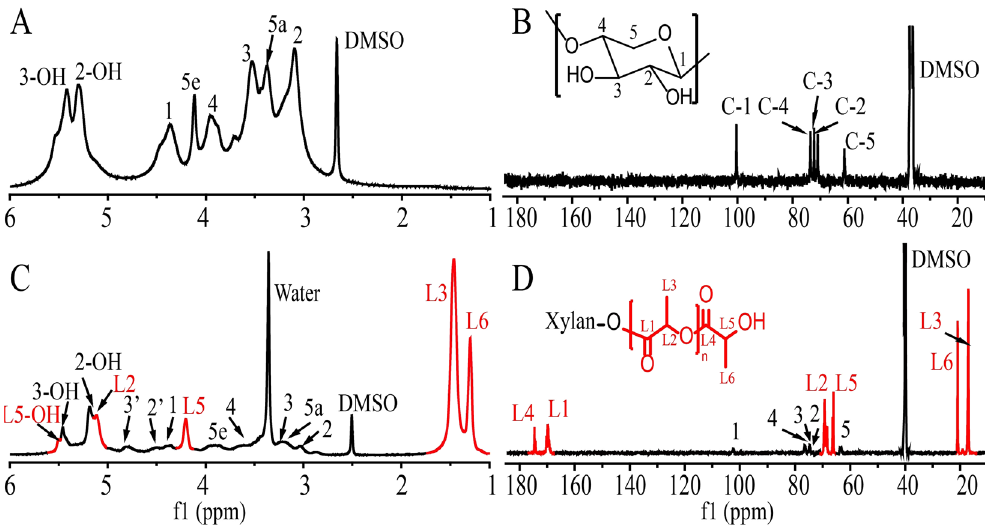
Figure 2. 1D-NMR spectra of unmodified xylan ( A for 1 H-NMR, B for 13 C-NMR) and xylan- g -PLA copolymer sample 21 (DS = 0.58, C for 1 H-NMR, D for 13